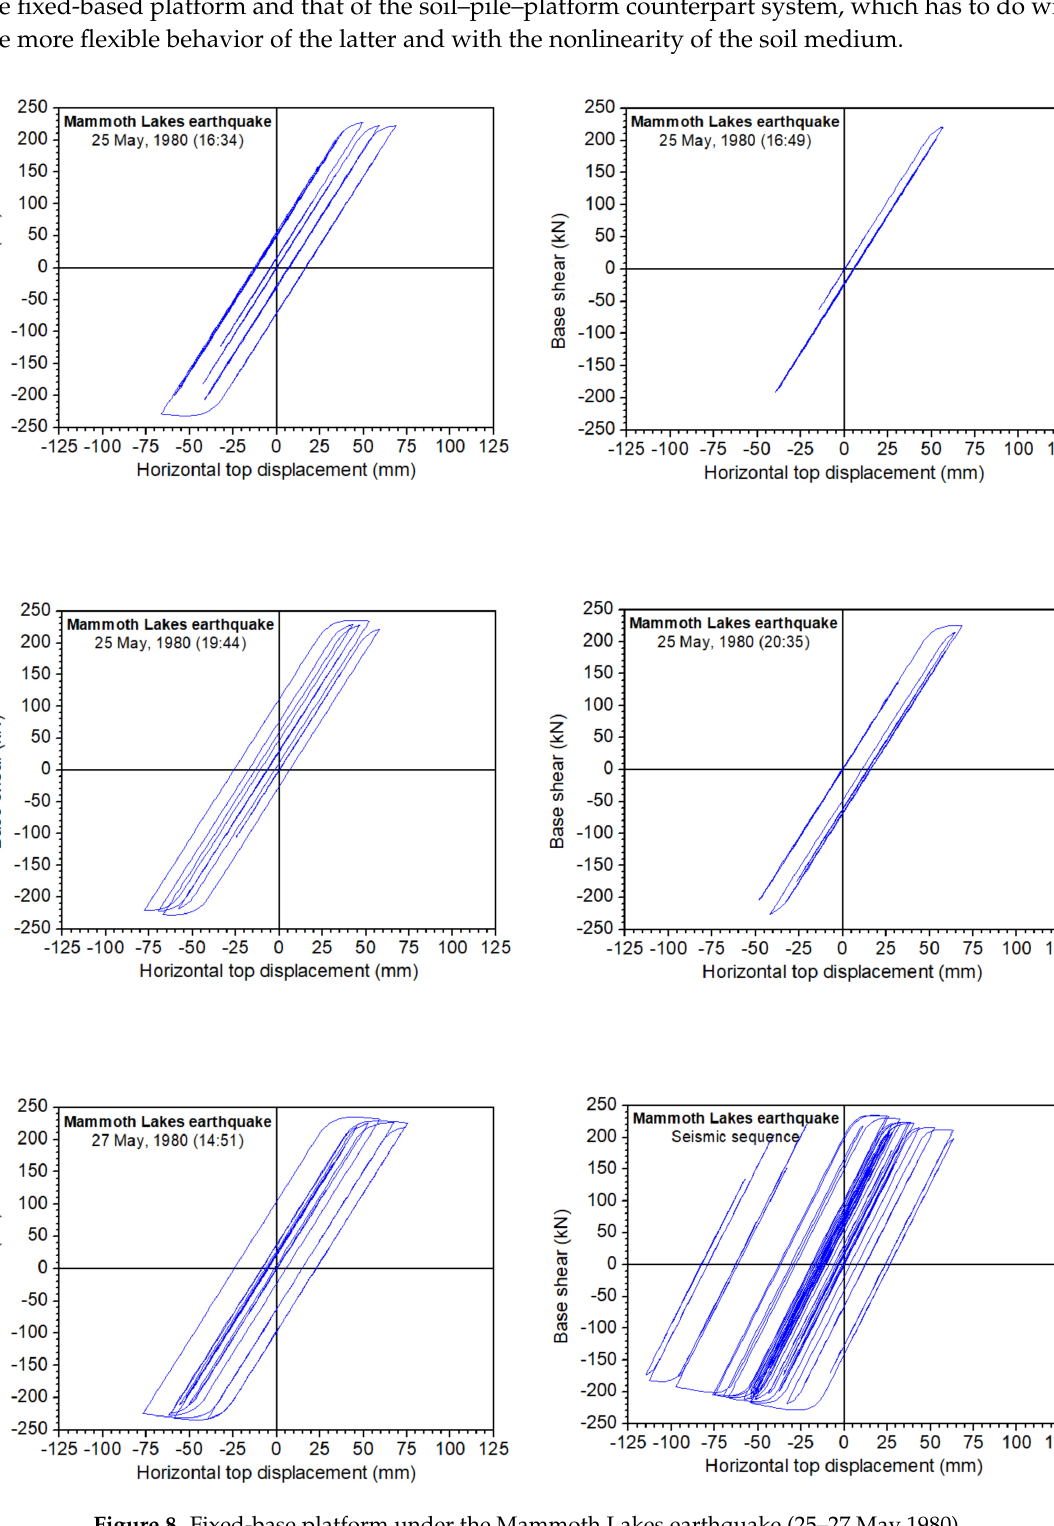
Figure 8. Fixed-base platform under the Mammoth Lakes earthquake (25–27 May 1980).